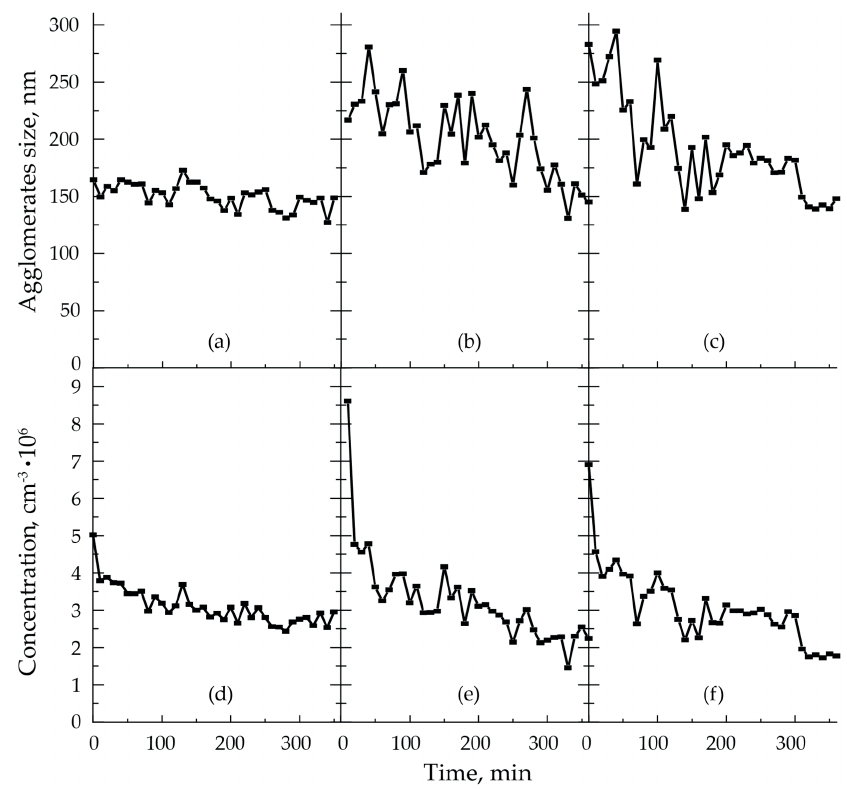
Figure 5. Time dependences of the modal size of NP agglomerates and their concentrations during the electrodes wear by the ODP for electrodes with ends ( a , d ) located parallel and at the angles of ( b , e ) 7° and ( c , f ) 15°.